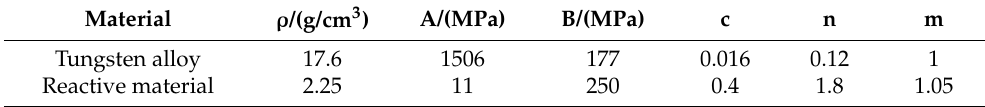
Table 2 . PLASTIC_KINEMATIC parameters.